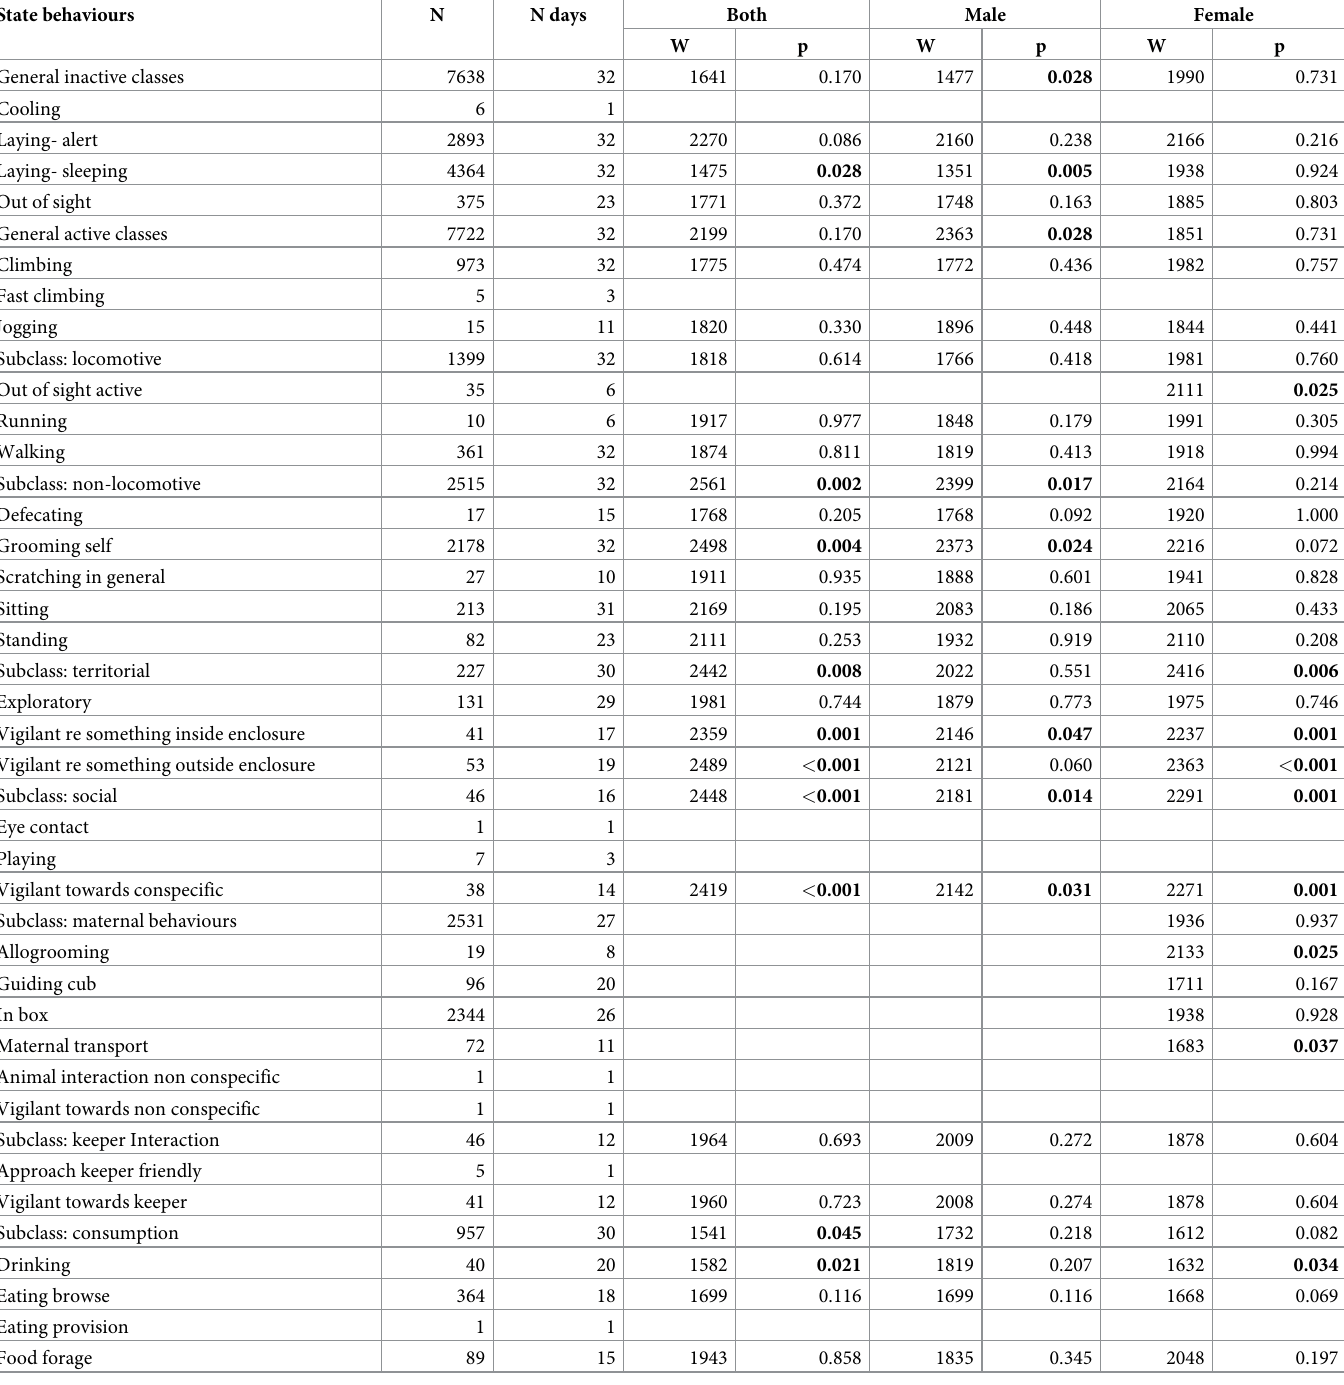
Table 1. Frequency of observation and results of Wilcoxon test state